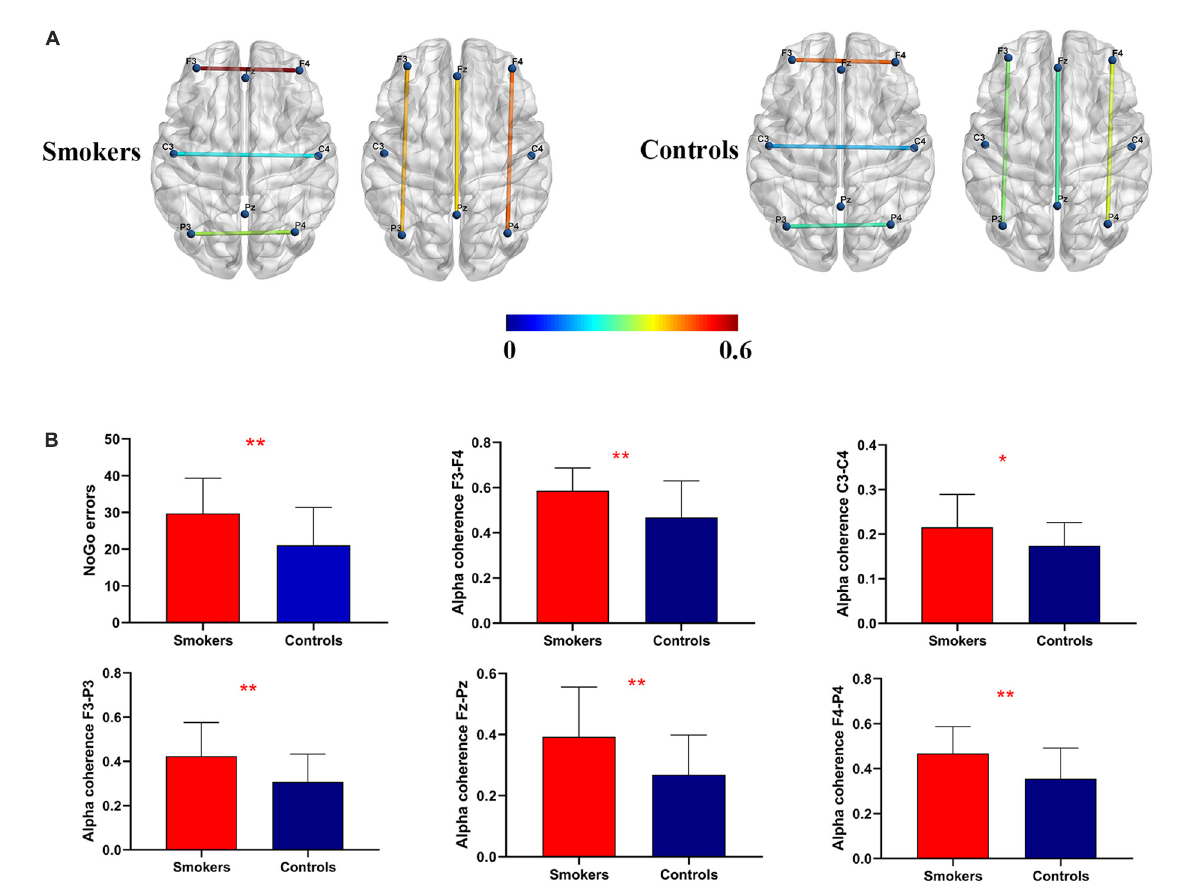
FIGURE1 Coherence mapping view and increased alpha coherence. (A) Cortical representation of the inter-hemispherical and frontal-parietal alpha coherence in young smokers (left) compared with healthy controls (right). (B) More NoGo errors and increased alpha coherence at C3–C4, F3–F4, F3–P3, F4–P4, and Fz–Pz electrode pairs were found in young smokers compared with healthy controls ( p <